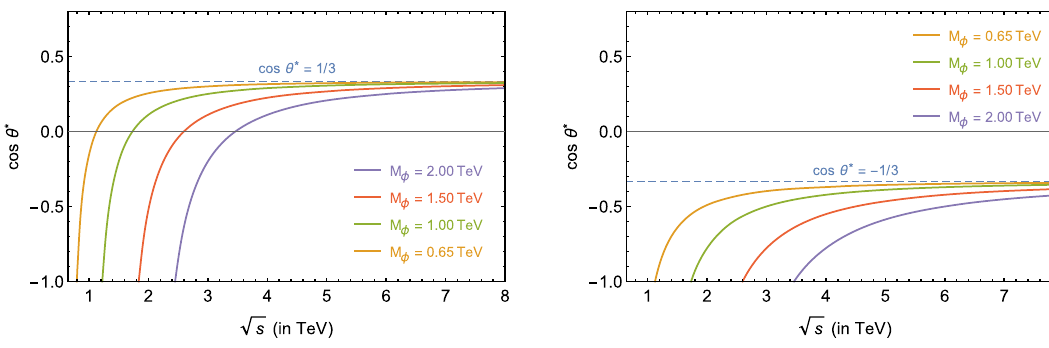
√ s for Q q = − 1 / 3 and Q ¯ q = − 2 / 3, respectively, for different masses of leptoquark